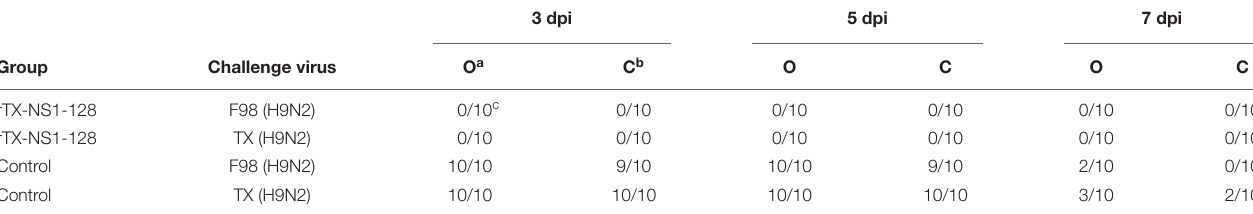
TABLE 4 | Protective efficacy induced by rTX-NS1-128 in SPF chickens.